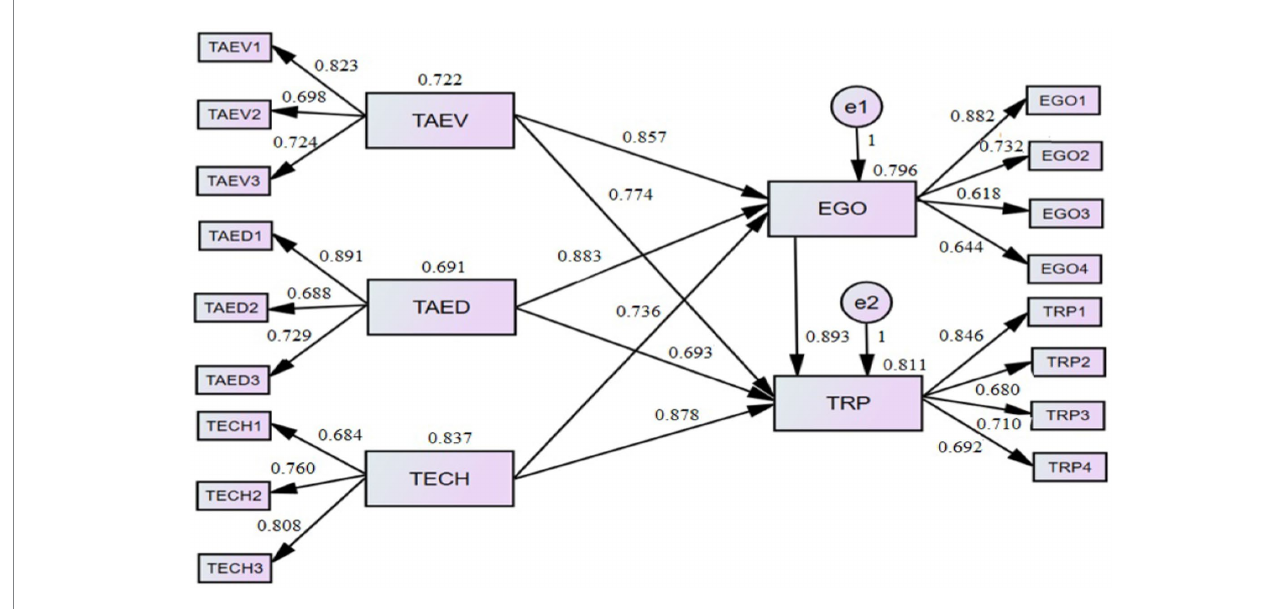
FIGURE 2 Conceptual framework path diagram.